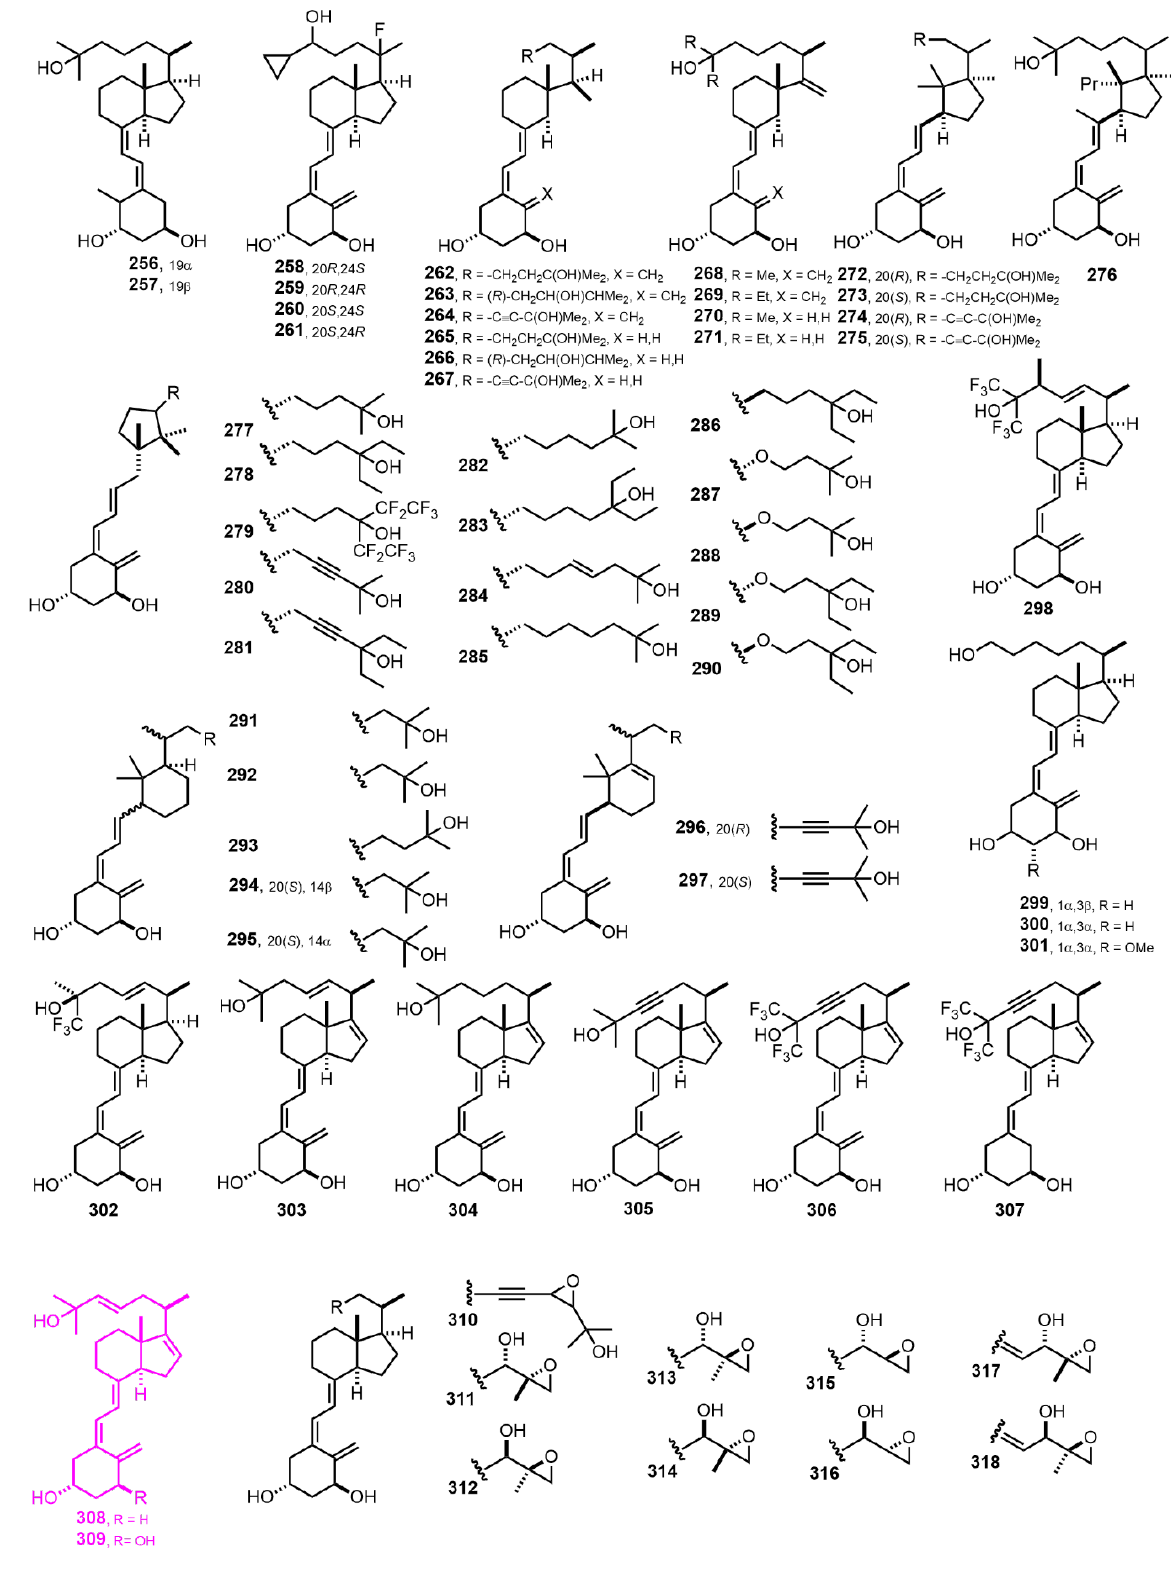
Figure 7. (1994–1997)